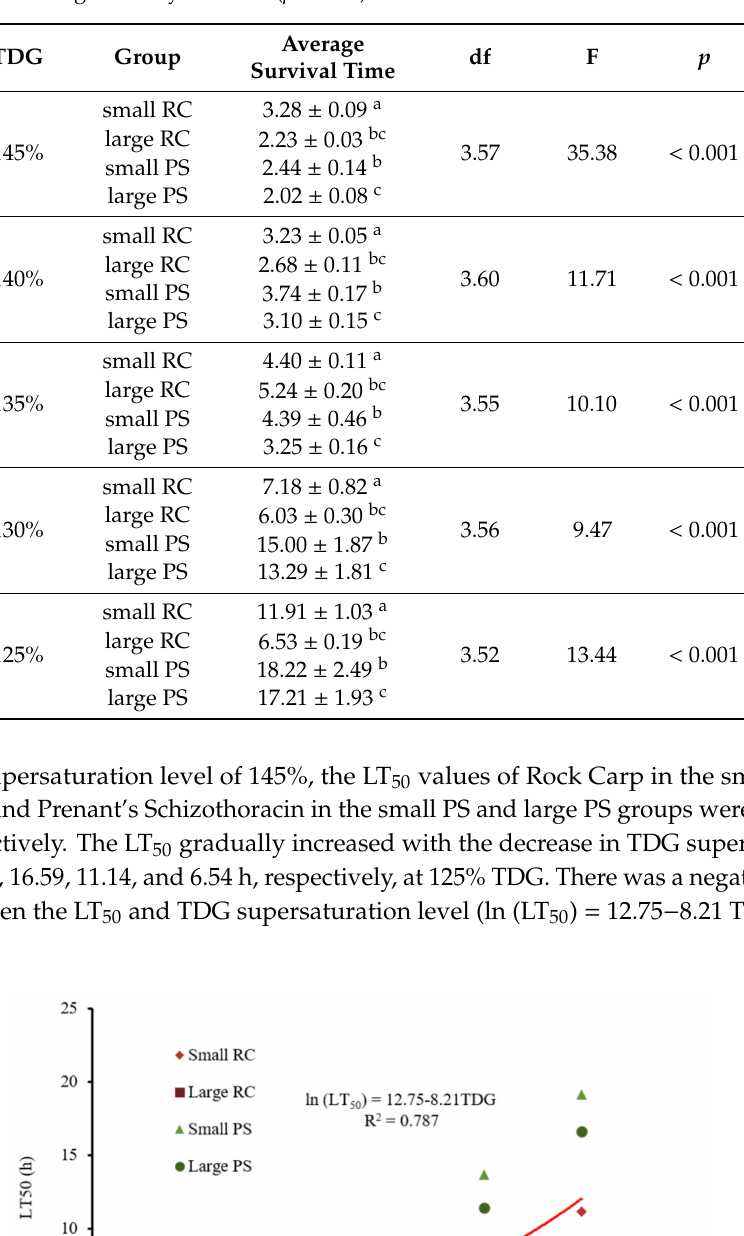
Table 2. Relationship between the average survival time and the TDG supersaturation, which varied with species and size at the di ff erent supersaturation levels. Values are expressed the as mean ± SE, n = 12–15. Letters following the average survival time indicates the results from a post hoc multiple comparison test between groups at each supersaturation level. Mean values that do not share a common lowercase letter are significantly di ff erent ( p < 0.05).